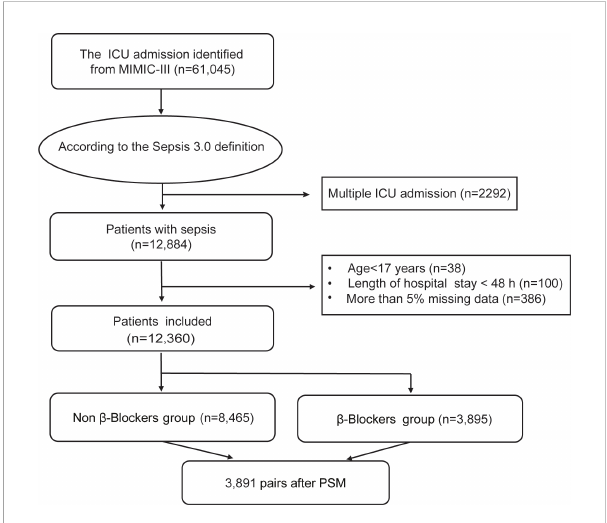
FIGURE 1 Flowchart of the patients screened in the study. ICU, intensive care unit; MIMIC-III, Multiparameter Intelligent Monitoring in Intensive Care Database III; SOFA, sequential organ failure assessment; PSM, propensity-score